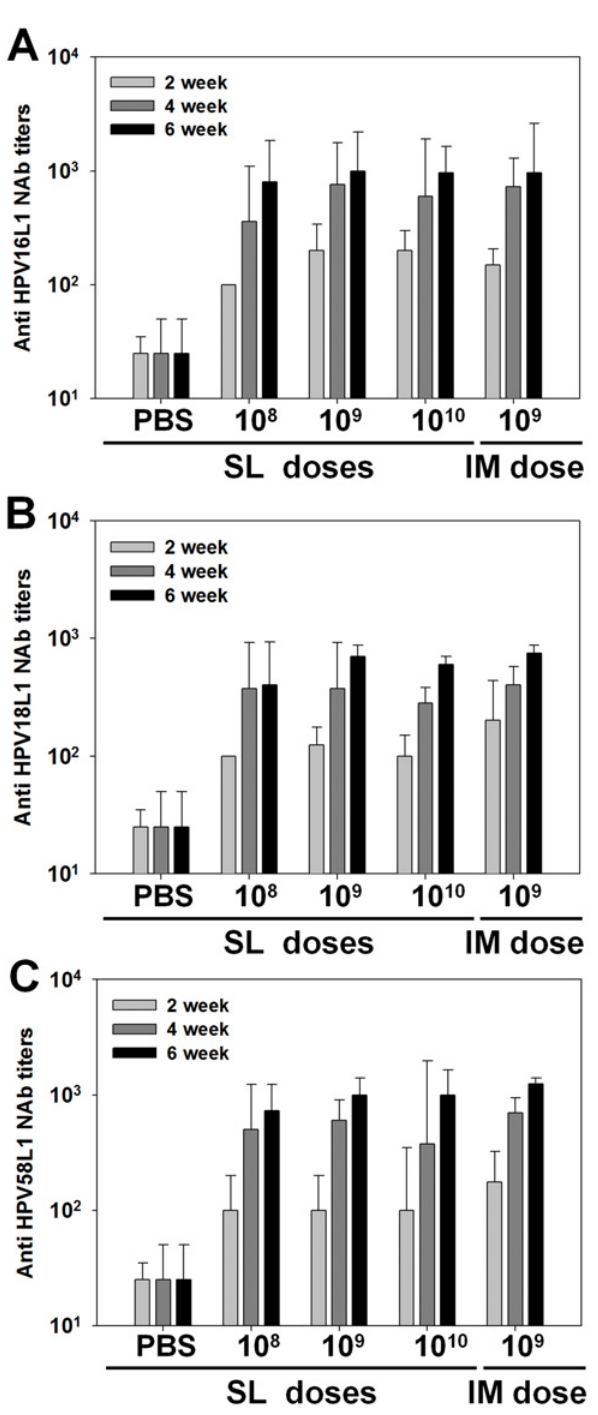
Fig 5. Induction of HPV type-specific neutralizing antibodies following SL or IM immunization. Mice were administered AcHERV-triHPV or PBS (control) three times over a 2-week interval by the SL or IM route. Mice were sublingually immunized with three different doses of AcHERV-triHPV (1×10 8 , 1×10 9 , and 1×10 10 copies per mouse) or immunized intramuscularly with 1×10 9 copies per mouse. Antigen-specific neutralizing antibody titers against HPV16L1 (A), HPV18L1 (B), and HPV58L1 (C) were determined by SEAP assay. Neutralization assays were performed using serially diluted mouse sera and HPV16, -18, or -58 PVs. Data are expressed as geometric means (log) of reciprocal serum dilutions that yielded a 50% reduction in SEAP (n = 5).